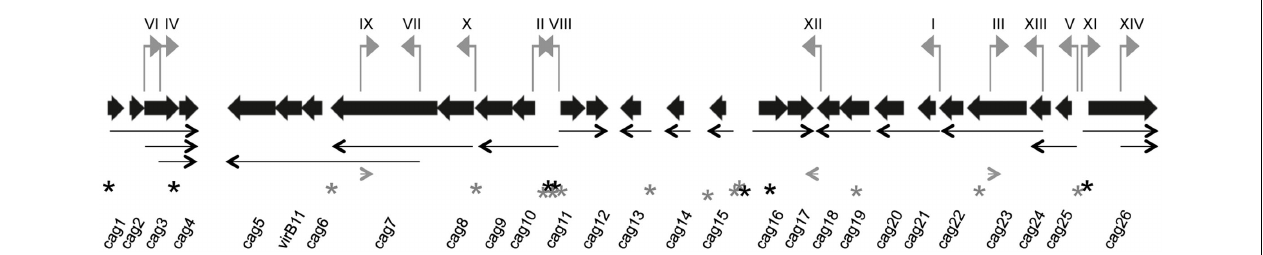
pointing in the direction they direct transcription and positioned in their cag PAI location.Thin black arrows represent 17 of the 20 proposed transcripts and gray arrowheads represent the three potential antisense transcript start points. All arrows point in the direction of transcription.Transcription start sites identified in Sharma et al. (2010) are indicated by an asterisk ( ∗ ); black asterisks indicate the transcription start site is on the plus strand and gray asterisks indicate the minus